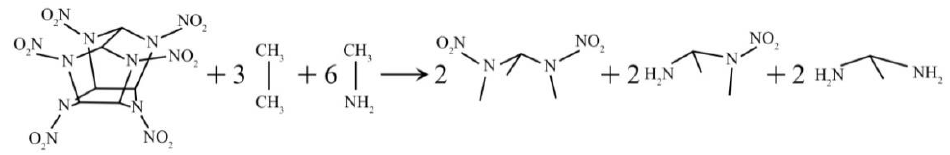
Figure 12. The homodesmotic reaction used to obtain the strain energy of CL-20 framework.